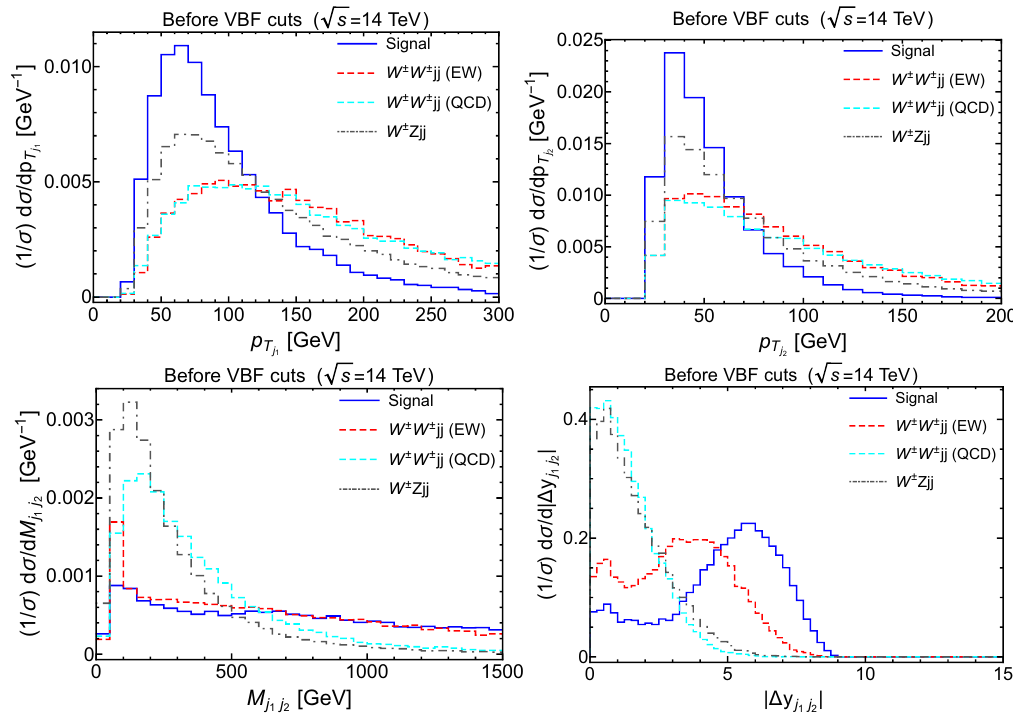
Figure 6 . Jet kinematic distributions of the signal and SM backgrounds W (cid:6) W (cid:6) jj (EW), W (cid:6) W (cid:6) jj (QCD) and W (cid:6) Zjj (QCD+EW) before VBF cuts. The top left, and right panels are respectively for the p T distributions of the leading jet j 1 and the sub-leading jet j 2 , and the lower left and right panels are respectively for the invariant mass M j j (cid:1) y j j of the two 1 j 2